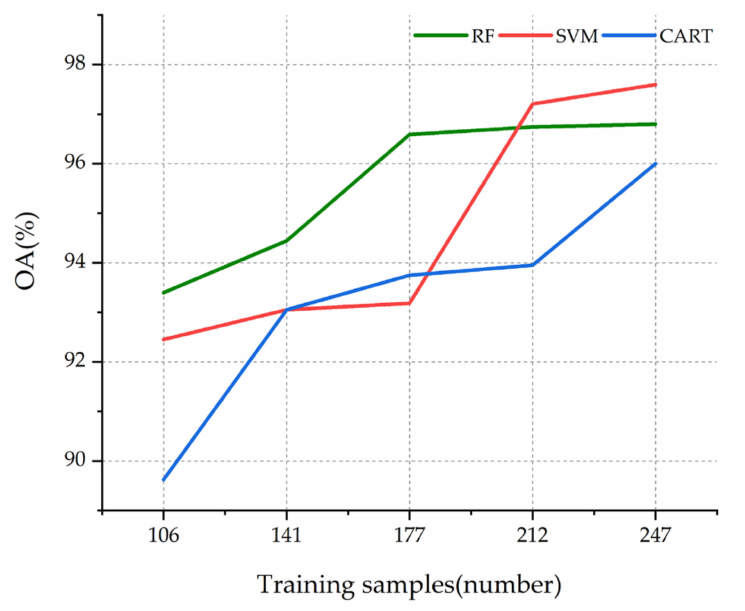
Figure 5. Accuracy of the different number of training samples for three machine learning